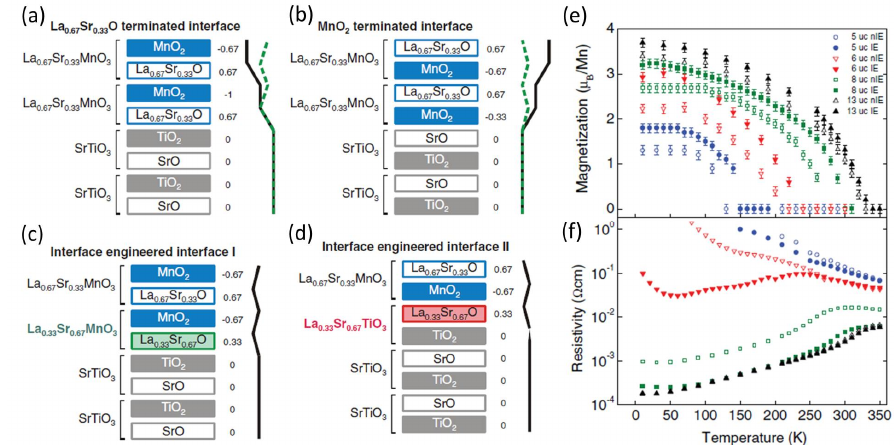
Figure 10. Polar catastrophe model of LSMO film on STO. The termination of the STO substrate is TiO 2 in ( a , c ), and is SrO in ( b , d ). The black line and green dotted line indicate the electrostatic potential profile before and after charge transfer, respectively. Comparison of ( e ) magnetization and ( f ) transport properties between non-interface-engineered (nIE) and interface-engineered (IE) LSMO films. Reproduced with permission from Boschker et al . [56]. Copyright 2012 John Wiley and Sons.